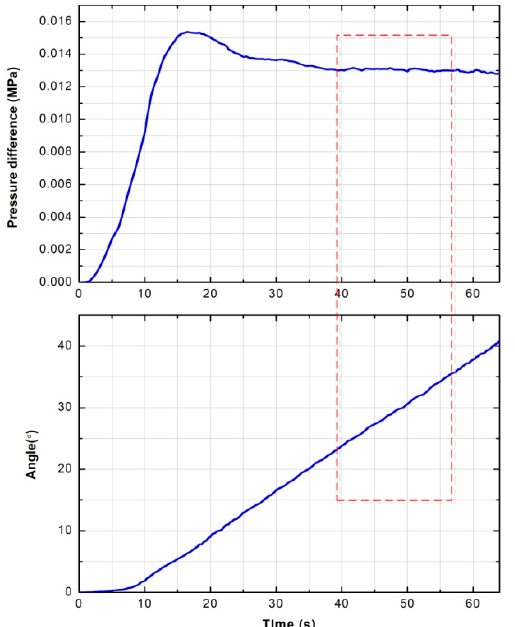
Figure 17. Dynamic process of the actuator at low speed.